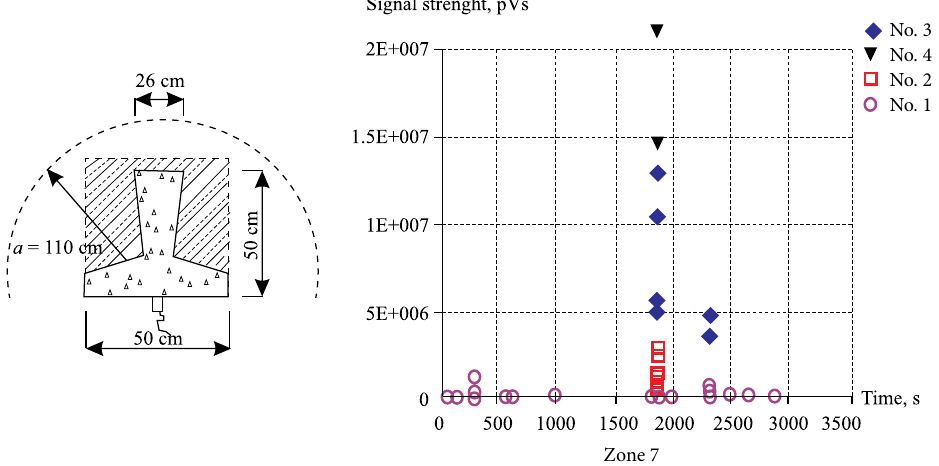
Fig. 7. Max range of the measuring surface and the AE signals registered in Zone